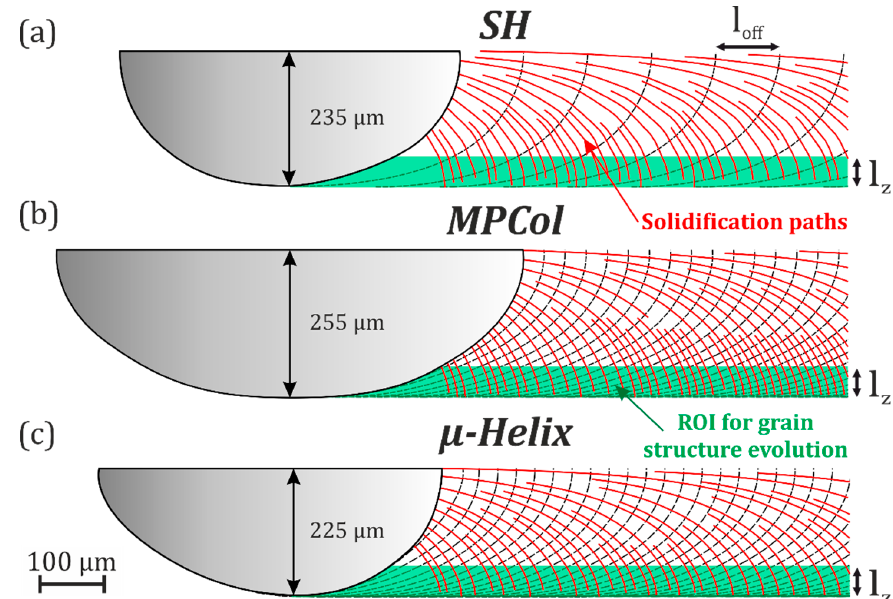
Figure 9. Numerical results from S AM PLE 2D (Simulation of Additive Manufacturing on the Powder scale using a Laser or Electron beam). The dark grey areas represent the melt pools for ( a ) SH, ( b ) MPCol, ( c ) µ-Helix. The dashed lines indicate previous pools. Due to remelting in subsequent beam passes and layers, only a small region of interest (ROI) remains for grain structure development (highlighted in green). The red streamlines resemble the orientation of G, i.e., the solidification paths.